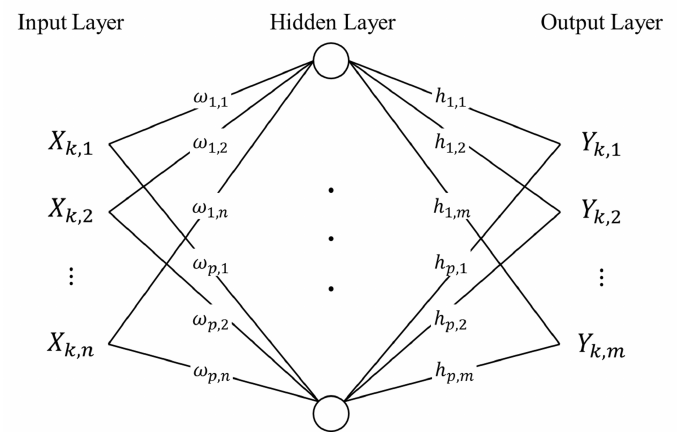
Figure 2. Example of a multi-layer